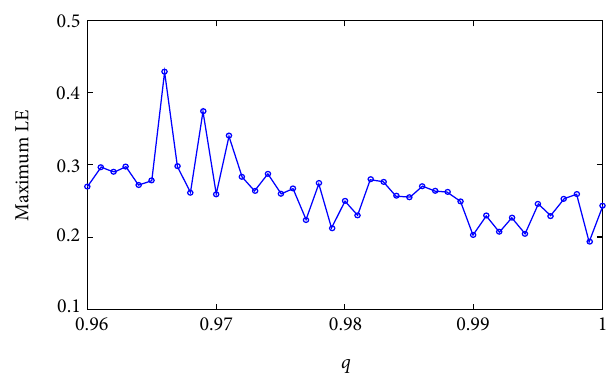
Figure 2: The maximum LE varies with fractional-order